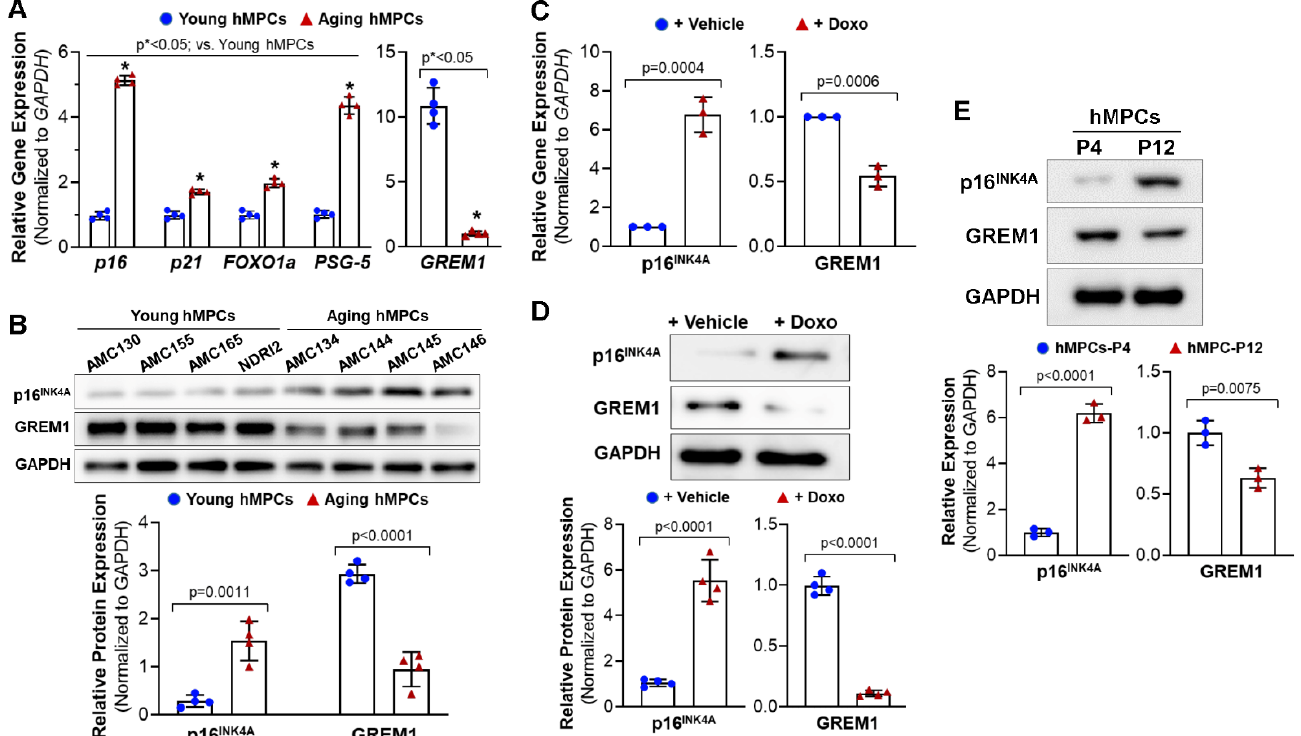
Figure 1. Decreased expression of GREM1 is associated with the aging/senescence of cardiac mesenchymal progenitor cells (hMPCs). ( A ) Gene expression of cell senescent markers (p16, p21, FOXO1a, and PSG5, as well as GREM1) in four lines of pediatric and aging hMPCs. ( B ) Western blot analysis for the protein expression of p 16INK4A and GREM1 in four lines of pediatric and aging hMPCs. ( C ) Gene expression of p16 INK4A and GREM1 in the pediatric hMPCs with 12 h doxorubicin-induced cell senescence. ( D ) Western blot analysis for the protein expression of p16 INK4A and GREM1 in the pediatric hMPCs with 12 h doxorubicin-induced cell senescence. ( E ) Western blot analysis for the protein expression of p16 INK4A and GREM1 in the pediatric hMPCs with different passage number following replicative senescence. Data are mean ± SEM. p value was calculated by unpaired Student’s t -test, n ≥ 3 independent experiments. * indicated the significant difference compared to the control